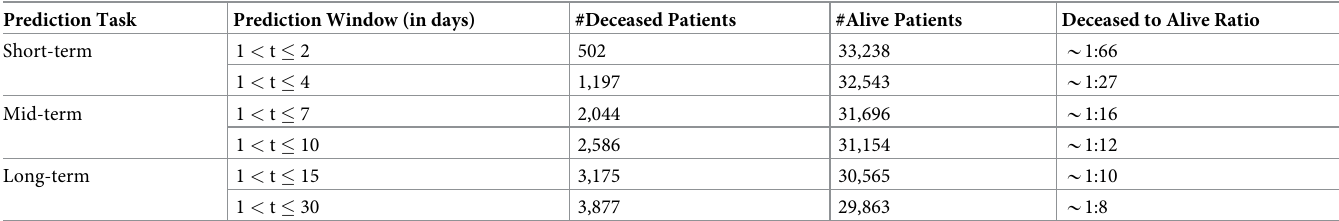
Table 1. Class distribution for short/mid/long-term prediction window.